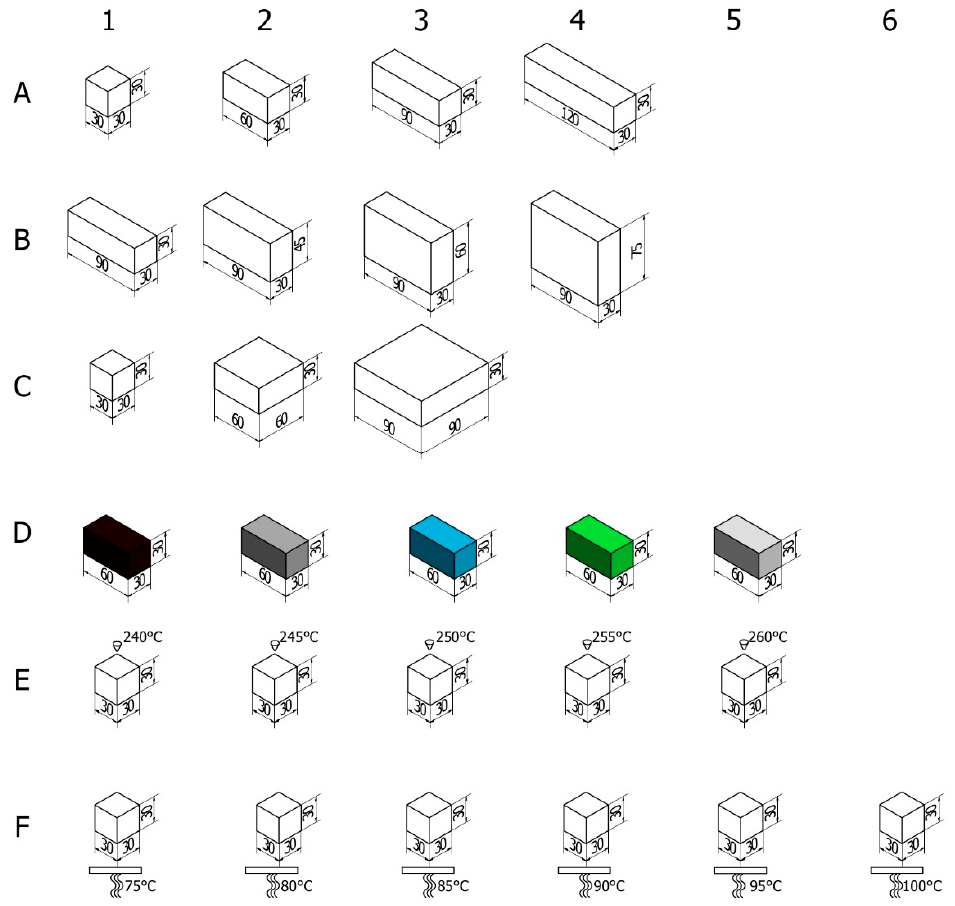
Figure 4. Graphics of various printouts. Group ( A ) changes length, group ( B ) changes height, group ( C ) surface area, group ( D ) color, ( E ) nozzle temperature, and ( F ) bed temperature.